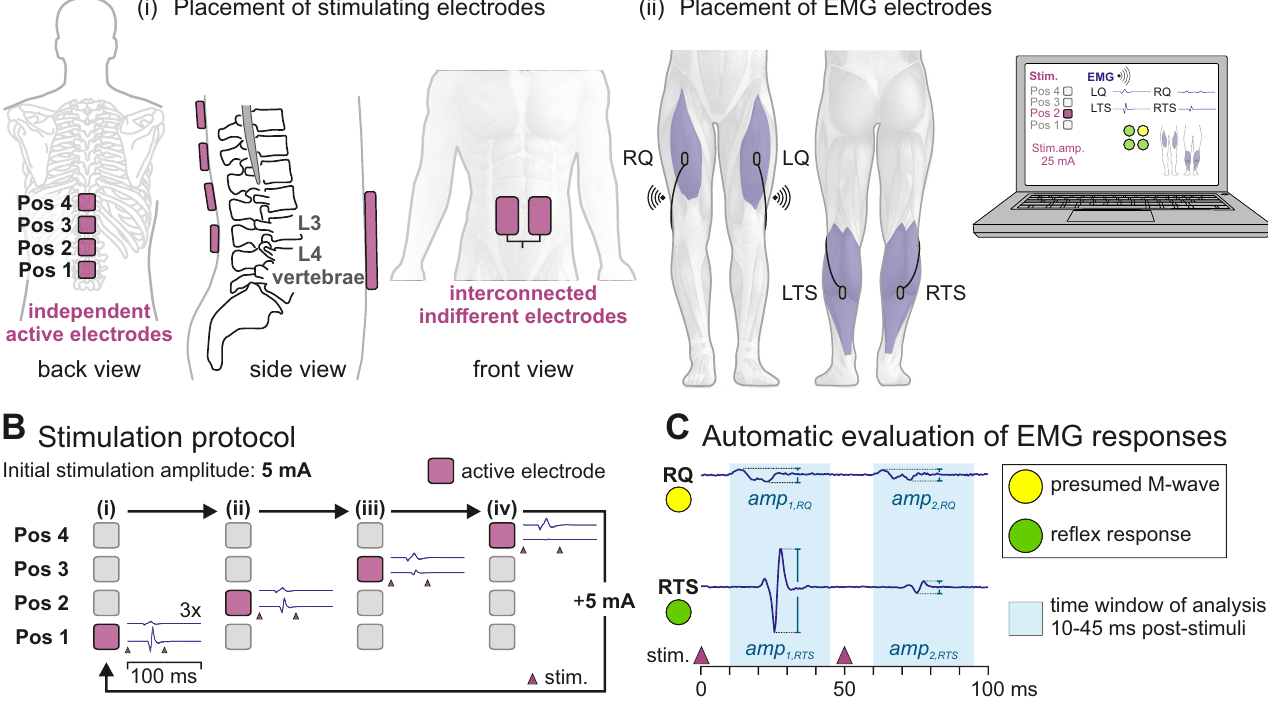
Figure 1. Automated stimulation and recording setup for lumbosacral posterior root stimulation. ( A ) (i) Separate active electrodes were placed at four rostrocaudal positions over the spine (Pos 1–4), with the most caudal electrode located between the L3 and L4 spinous processes. Two interconnected electrodes on the lower abdomen acted as common indifferent electrode. (ii) Surface electromyographic (EMG) recordings were acquired from right (R) and left (L) quadriceps (Q) and triceps surae (TS) muscle groups by using a two-channel sensor per lower limb. Information on the selected active electrode and the recorded EMG activity was transmitted to a laptop and displayed in a custom user interface. ( B ) The automated stimulation protocol systematically tested electrode positions 1–4 using three double stimuli per stimulation amplitude, starting with 5 mA. In each iteration of the protocol, the stimulation amplitude was increased by 5mA up to a maximum of 75 mA or the individually maximally tolerated amplitude. ( C ) The custom user interface allowed for the visualization of averaged EMG waveforms of muscle responses elicited by the three double stimuli with a given amplitude, here exemplarily shown for RQ and RTS. Peak-to-peak amplitudes of the responses to the respective first and second stimuli were automatically computed ( amp 1,RQ , amp 2,RQ , and amp 1,RTS and amp 2,RTS ). By applying the rules of the defined rating light system (Table2), the responses were automatically classified as being a presumed M-wave or reflex